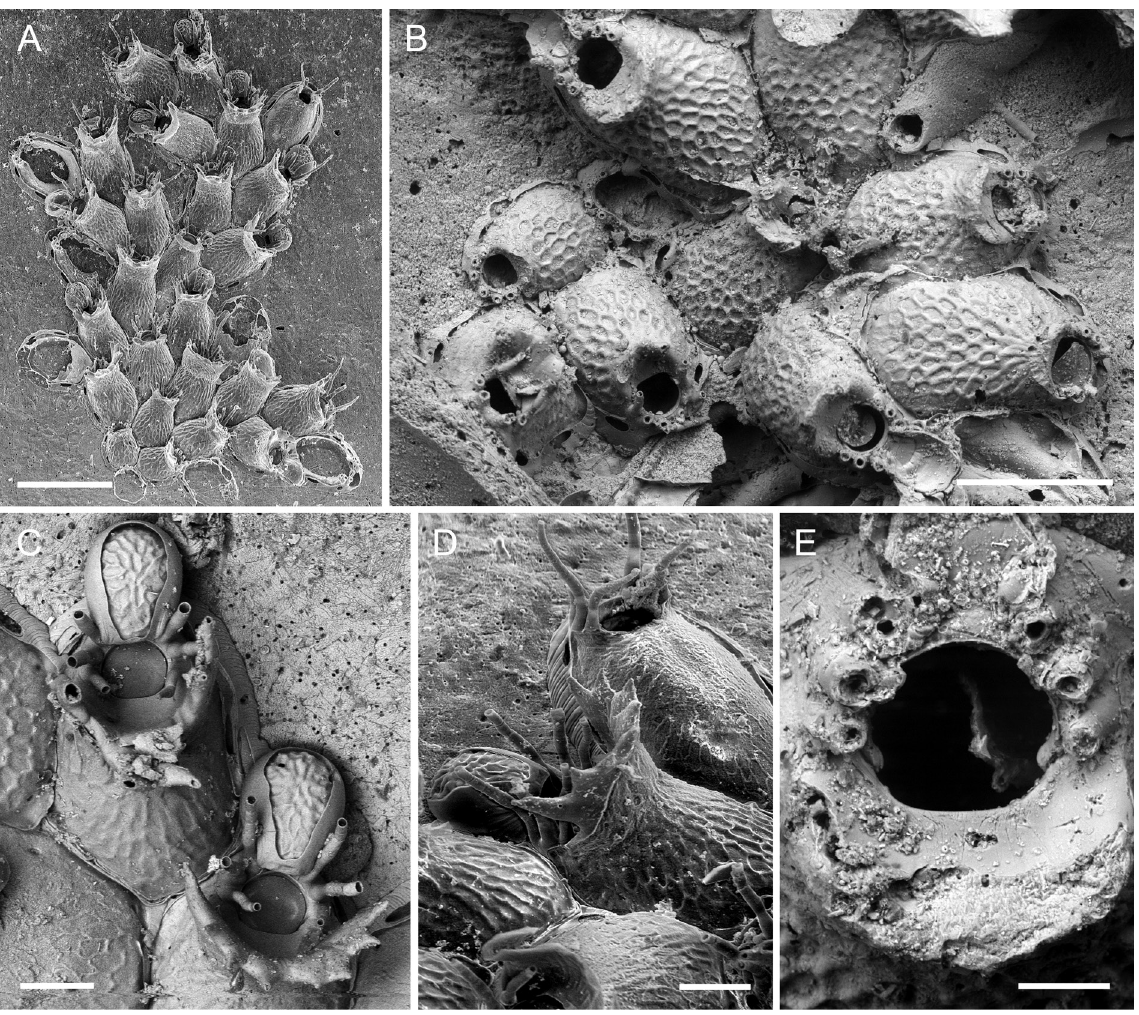
Fig. 9. Atlantisina gorringensis gen. et sp. nov., Gorringe Bank. A . Overview of holotype (MNHN- IB-2014-70). B . Periancestrular region, the constricted oral region of the partly overgrown ancestrula is to the left (paratype OLL 2016/147). C . Two ovicellate zooids, the lower one with a well-preserved suboral crest (MNHN-IB-2014-70). D . The same zooid in lateral view (MNHN-IB-2014-70). E . Close- up of orifice (OLL 2016/147). Scale bars: A = 500 µm; B = 300 µm; C–D = 100 µm; E = 50